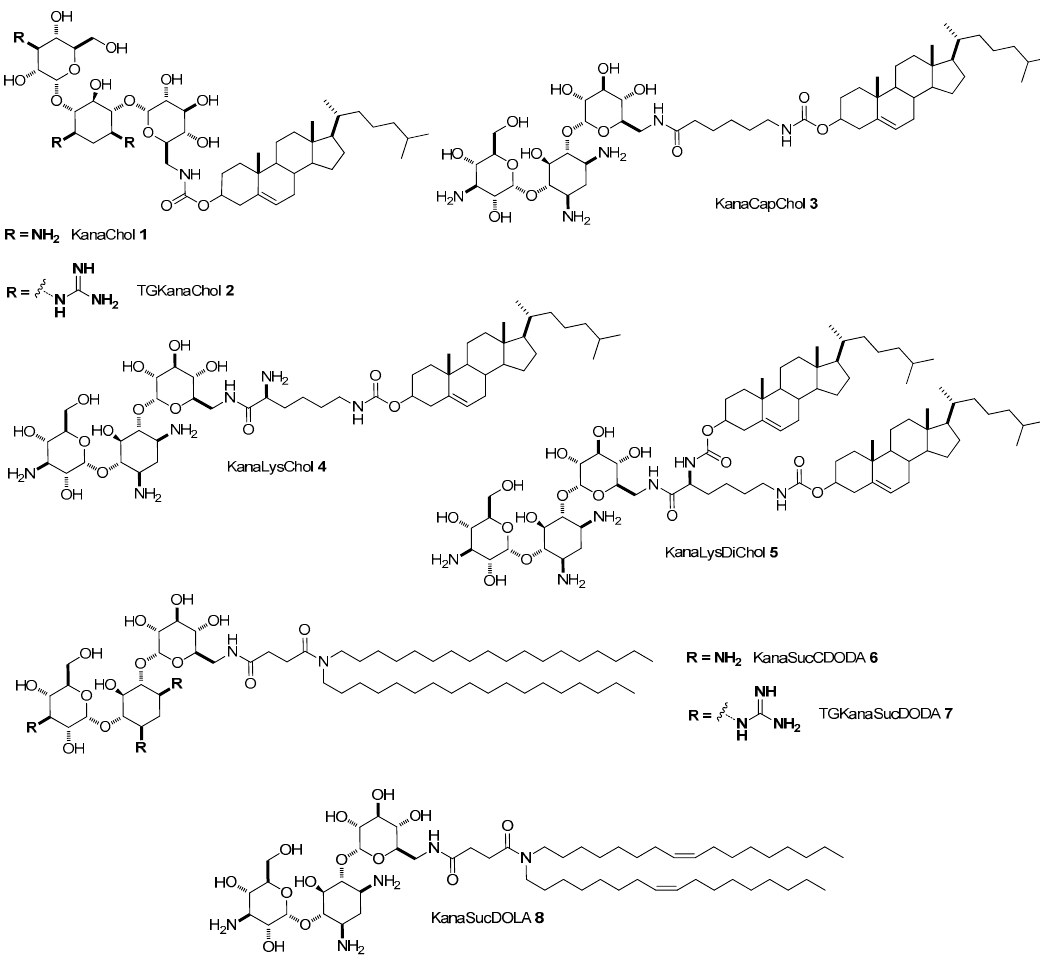
Figure 4. Structures of Kanamycin A-based lipids 1–8 .